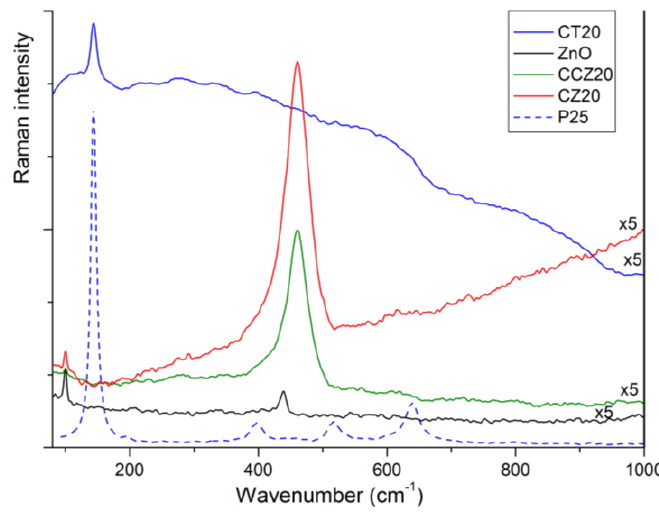
Figure 4. Raman spectra of pristine and doped materials.